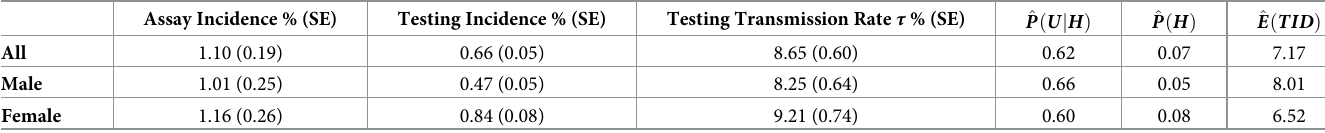
Table 1. Incidence results for KAIS 2007. Assay Incidence % (SE) Testing Incidence % (SE) Testing Transmission Rate τ % (SE) ^ P ð U j H Þ ^ P ð H Þ All 1.10